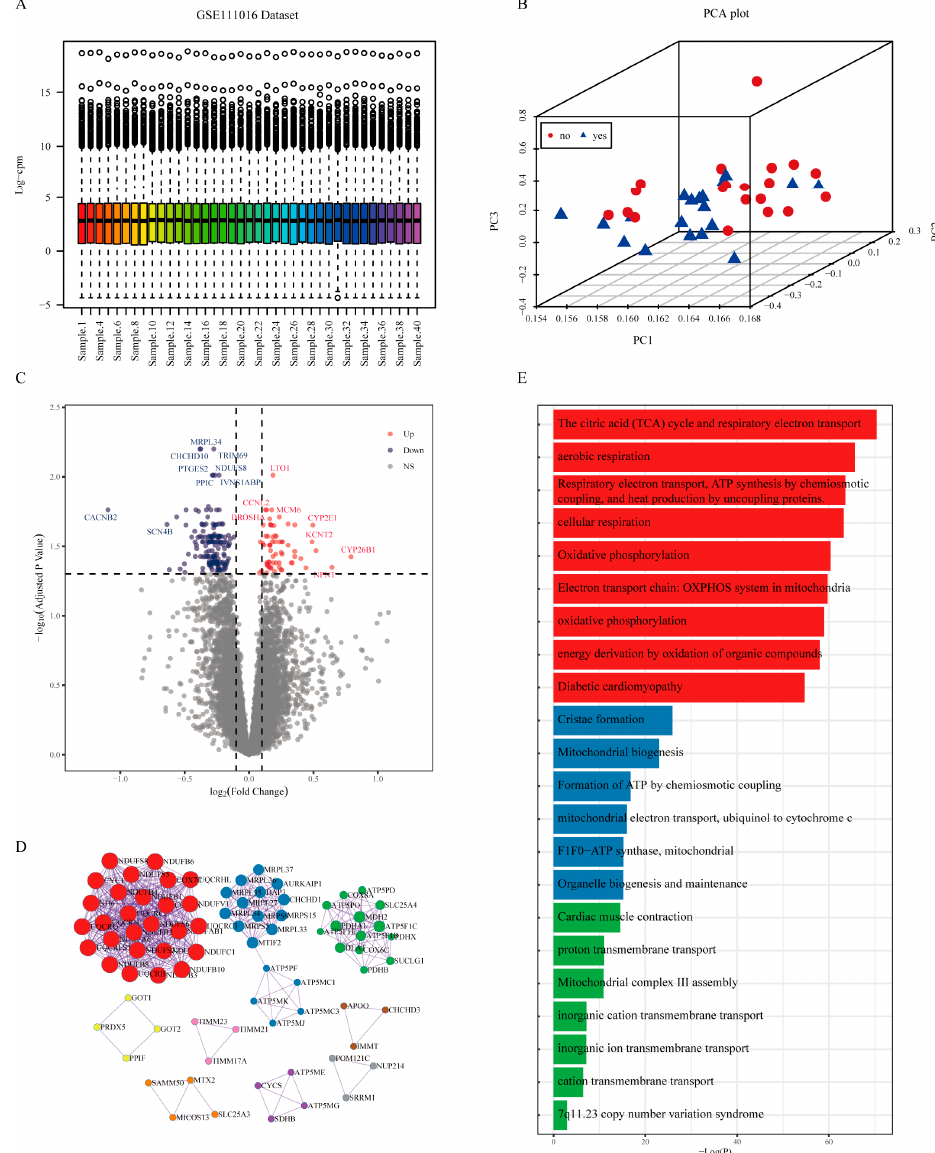
Figure 2. ( A ) Raw count quality control assessment of GSE111016 Dataset. ( B ) Principal component analysis (PCA) of GSE111016. ( C ) A volcano plot of the differential expression analysis of GSE111016. ( D ) The enrichment analysis of differentially expressed genes led to the extraction of 9 sub-networks by Metascape [16] . ( E ) Pathway enrichment analysis of the top three sub-networks.